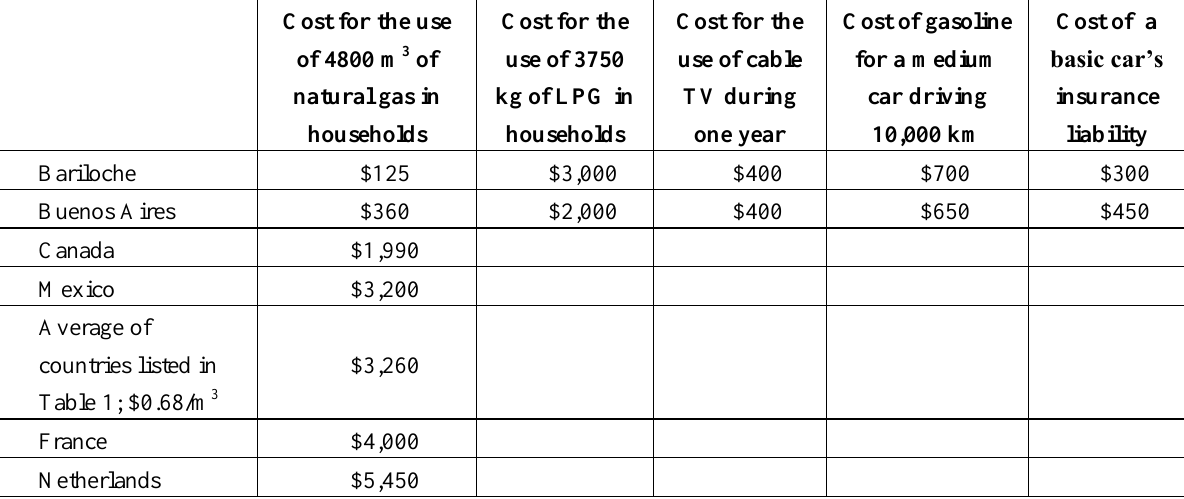
Table 2. Natural gas cost compared with LPG and other households’ common expenses (2008).